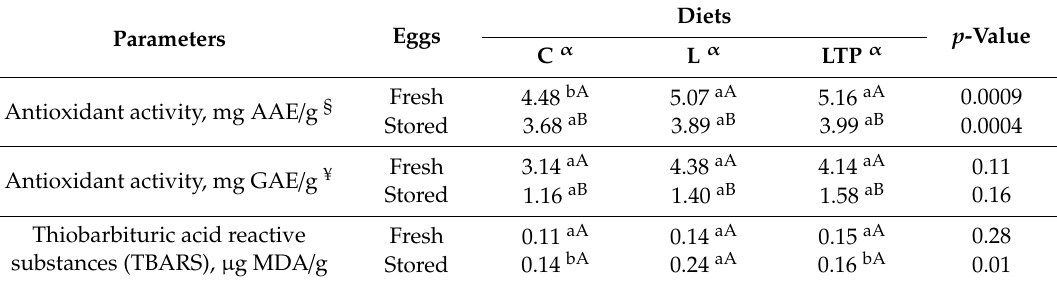
Table 4. Egg yolk lipid oxidative status before and after storage at 4 ◦ C for one month.